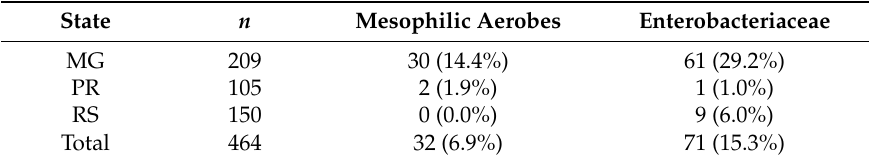
Table 4. Number of carcasses after final washing (step 4) with counts above the criteria established by (EC) No. 1441/2007 for mesophilic aerobes (M = 5 log cfu/cm 2 ) and Enterobacteriaceae (M = 2.5 log cfu/cm 2